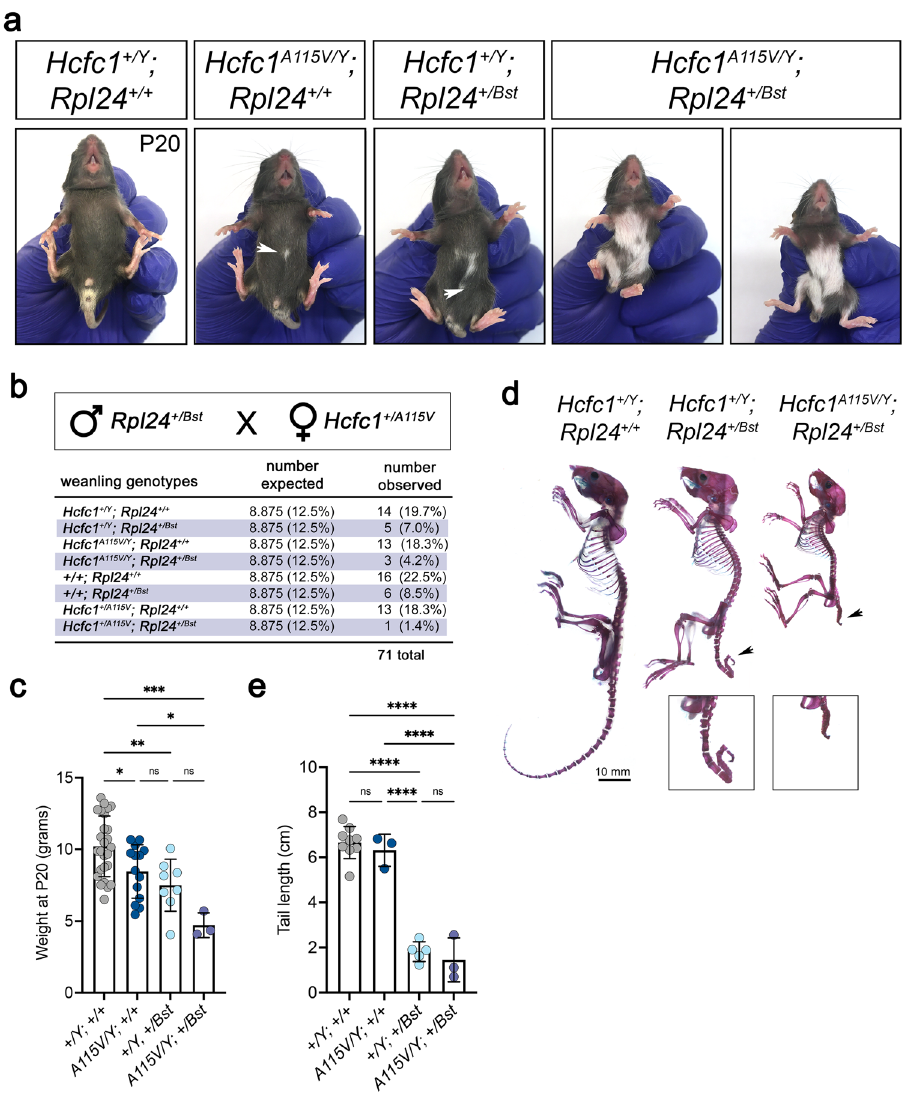
Fig. 9 The Hcfc1 A115V and Rpl24 Bst alleles genetically interact. a Expanded belly spot in the Hcfc1 A115V/Y ; Rpl24 + /Bst mice. b Results of genetic crosses between Rpl24 + /Bst and Hcfc1 + /A115V mice. c Weight measurements showing a trend of increased runtedness in the Hcfc1 A115V/Y ; Rpl24 + /Bst mice as compared to Hcfc1 + /A115V and Rpl24 + /Bst . d , e Skeleton preparations and tail length measurements showing that 2/3 Hcfc1 A115V/Y ; Rpl24 + /Bst mice exhibit a more severe shortening of the tail as compared to the Rpl24 + /Bst mice. All quanti fi ed data are shown as mean ± SEM and n ≥ 3 biologically independent samples per genotype. Statistically signi fi cant differences between genotypes were determined using ANOVA and Tukey ’ s multiple comparisons